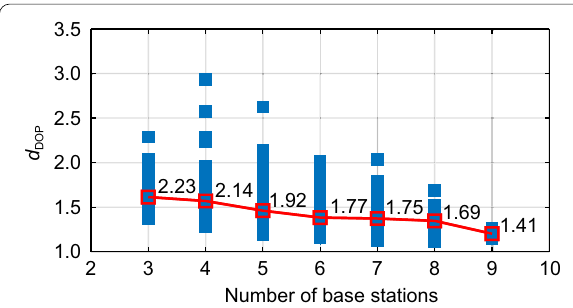
Fig. 8 Relationship between d DOP and the number of base